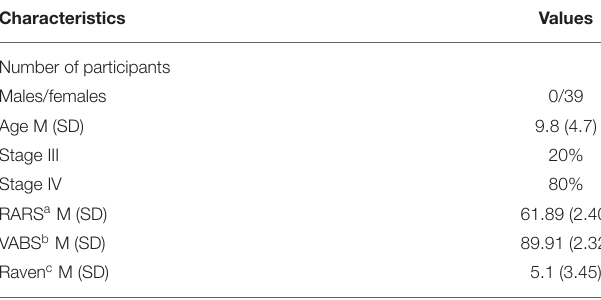
TABLE 1 | Means (M) and (standard deviations) of characteristics of all